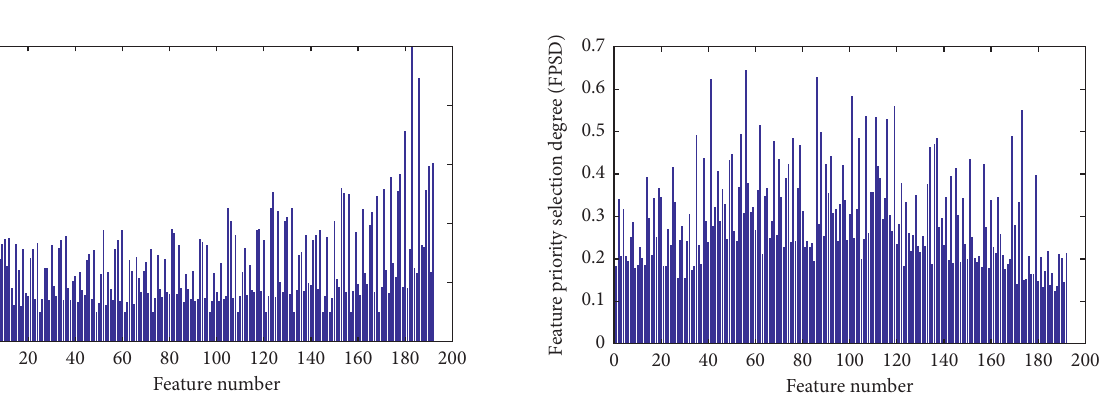
Figure 13: The feature priority selection degree of 192 statistical features ( μ � 0 . 6).